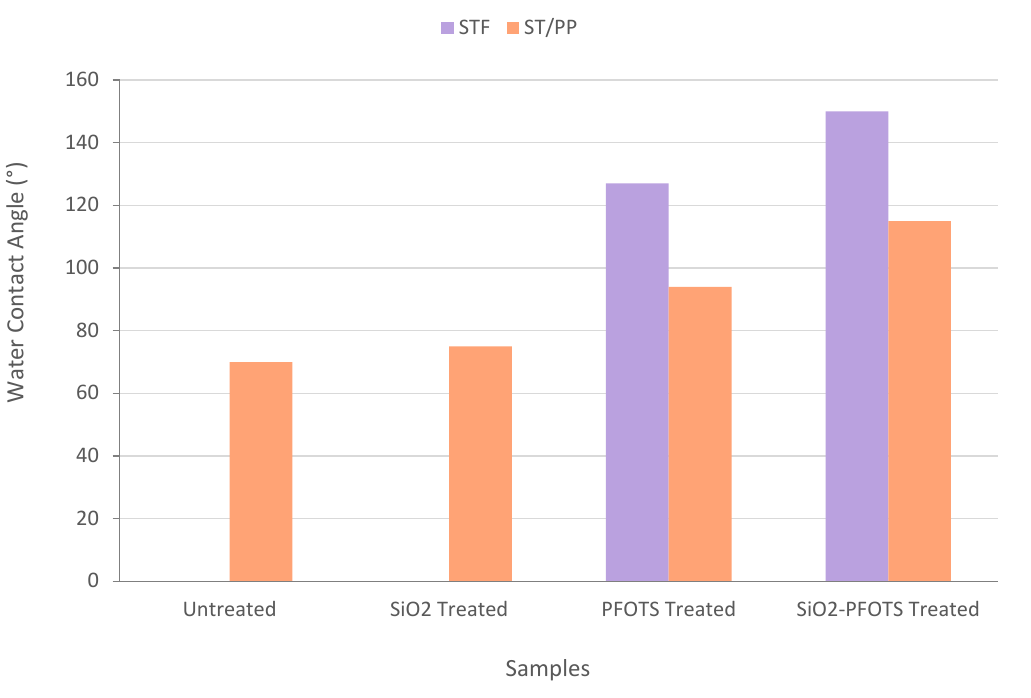
Figure 9. Comparison between the water contact angle of STF and ST/PP composite with different treatments.